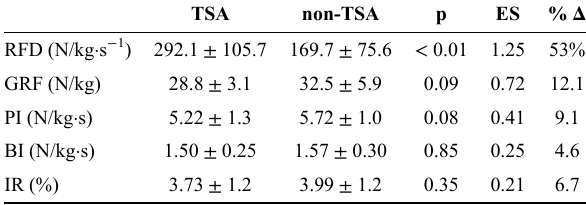
ratio; ES, effect size (Hedges’ g